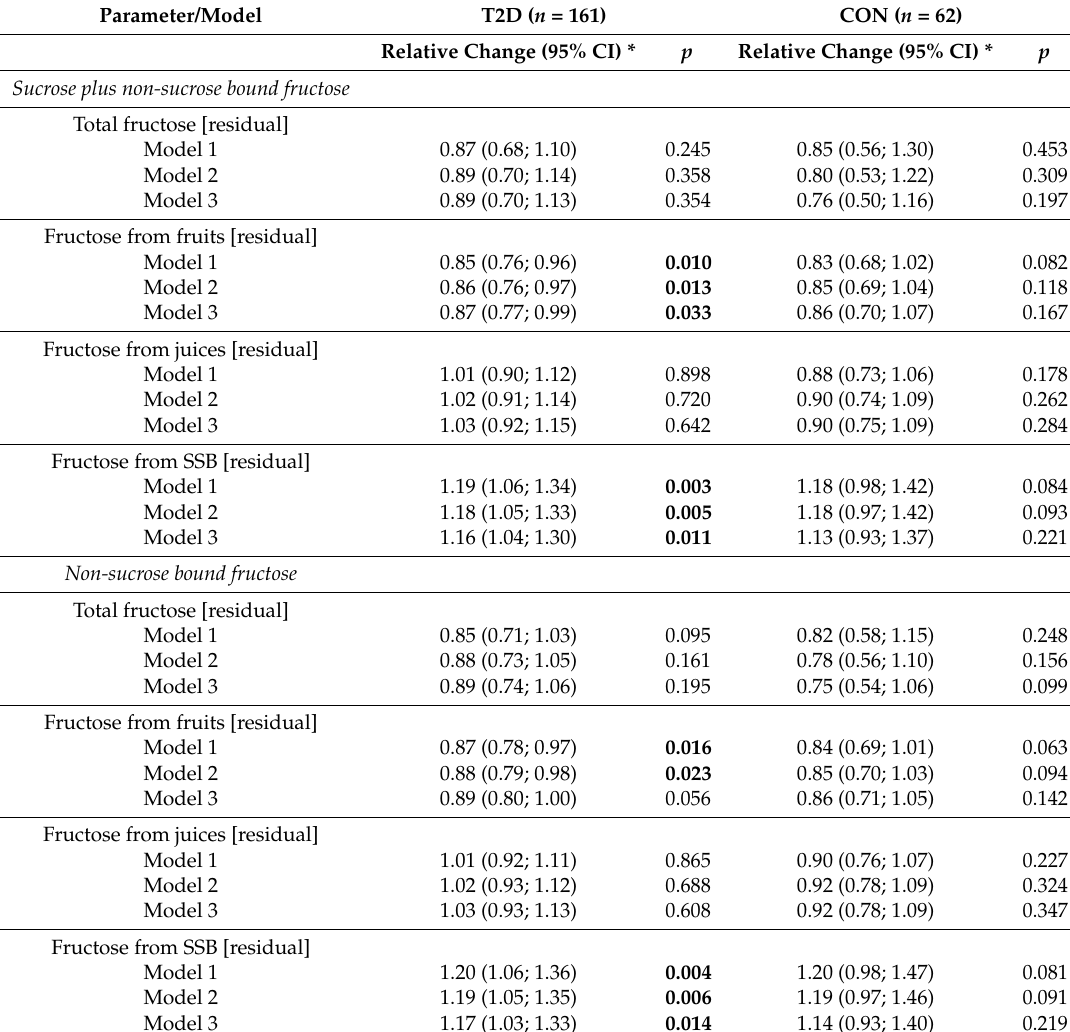
Table 4. Association of fructose intake with fatty liver index in patients with type 2 diabetes and individuals without